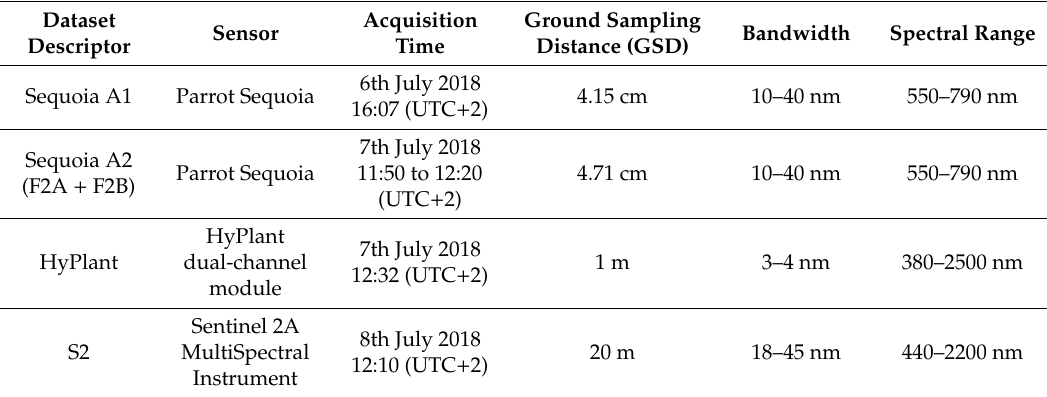
Table 1. Description of image datasets used within this study, including sensor, acquisition time, ground sampling distance (spatial resolution) and spectral bandwidths (spectral